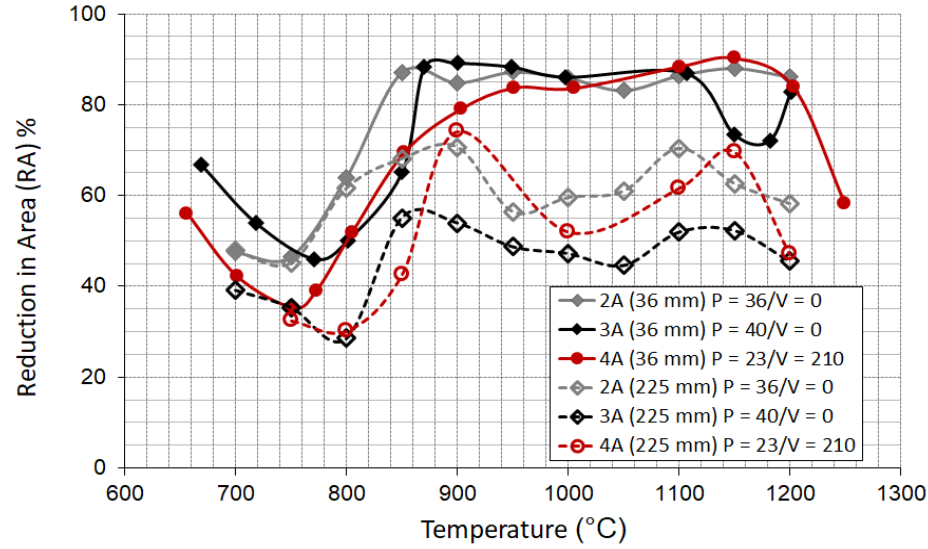
8 of 13 Figure 7. Hot ductility curves for the V-free steels (dashed lines) and V steels (solid lines) examined in the solution-treated condition. The hot ductility curves for the as-cast (225 mm) state are shown in Figure 8 (dashed lines, suffix 225 mm) for selected steels 2A–4A. They are compared with the solution- treated (36 mm) condition of the same alloys (solid lines, suffix 36 mm). At higher tem- peratures the hot ductility curves for the as-cast state are generally much worse than for the solution-treated condition. The as-cast tensile samples were cut 15 mm below the slab surface, in the columnar grain zone (Figure 3) where the austenite grain size was greater than 1 mm. This is a factor of ~10 times greater than the solution-treated specimens so it is likely that the coarse grain size explains the poorer high temperature behaviour. The increased scatter in the as-cast data makes it difficult to draw any firm conclusions about